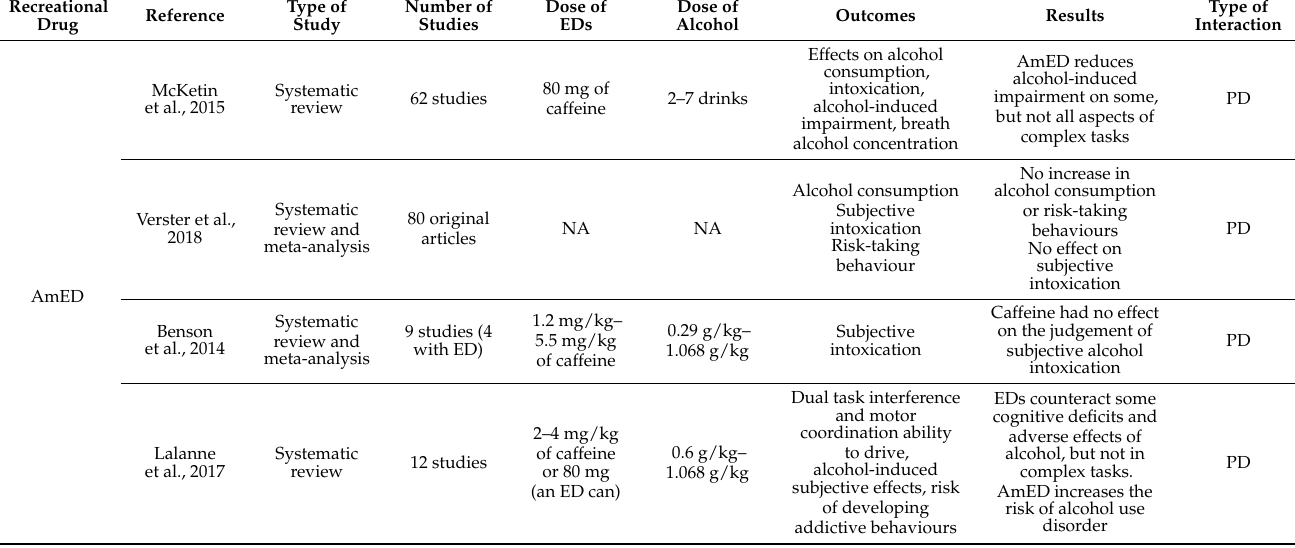
Table 2. Published systematic reviews of the effects of